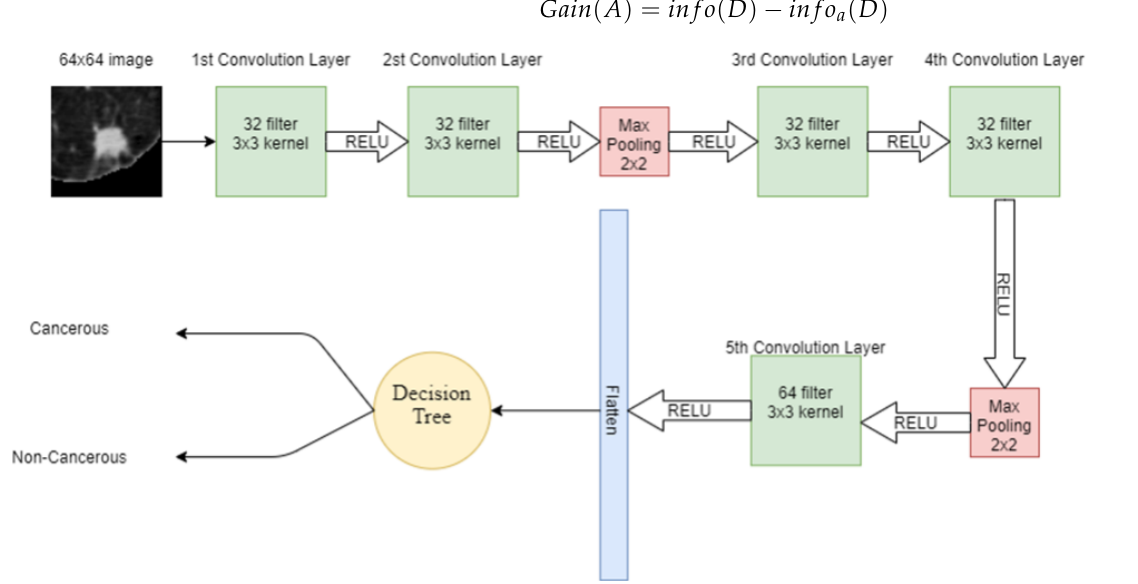
Figure 8. Proposed hybrid model combining CNN and DT.